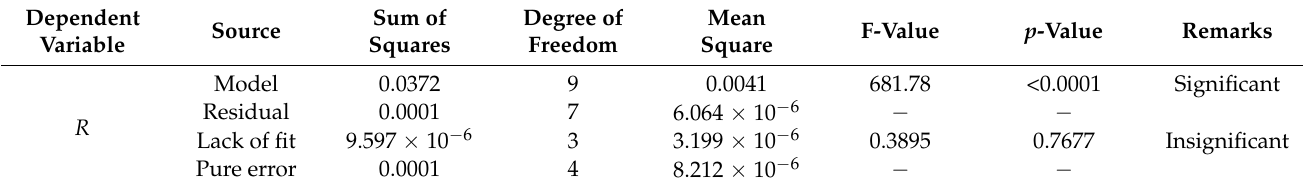
Table 4. ANOVA of the reduced quadratic model for extraction yields of parthenolide.